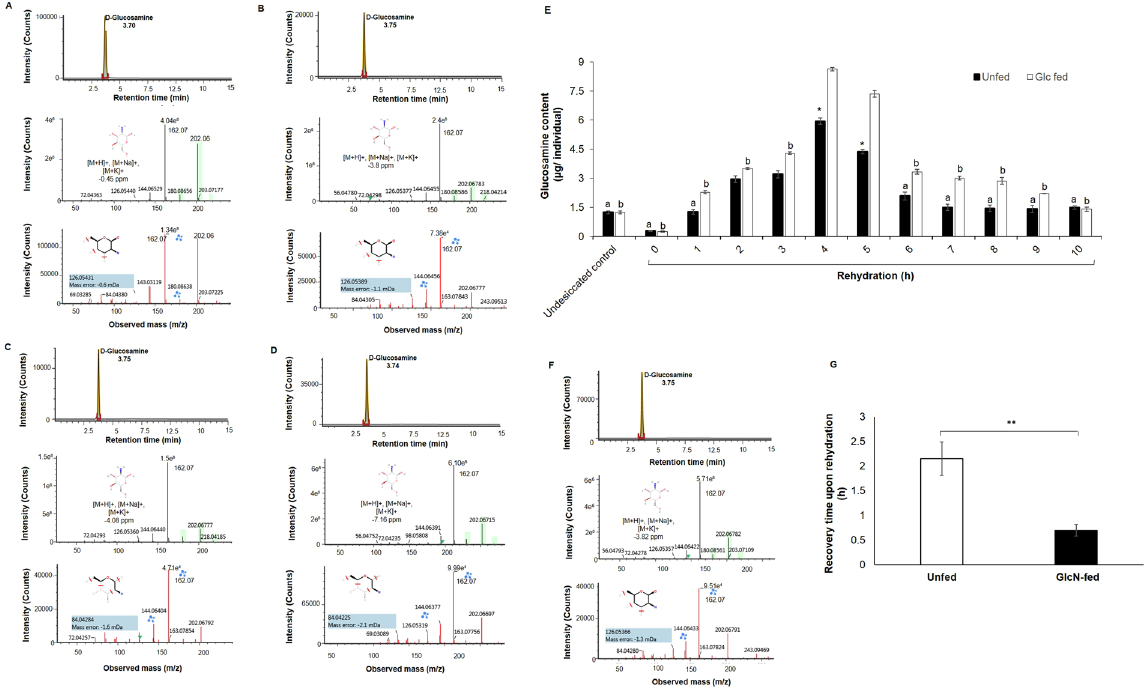
Figure 3. Discovery of glucosamine and the biosynthetic pathway followed during recovery post desiccation. ( A–D ) Representative UPLC-QToF-MS chromatograms indicating the detection of glucosamine. Glucosamine was identified as [M + H] + , [M + Na] + , [M + K] + with mass accuracy 0.45 ppm along with the confirmatory ions (162.07532 Da, 126.05370 Da and 84.04294 Da). ( A ) Standard glucosamine solution. ( B ) Undesiccated control. ( C ) 50 min desiccation. ( D ) 6 h rehydration. ( E ) Comparative glucosamine content in the fed and unfed larvae during rehydration. Of note, glucosamine levels were significantly higher in the fed group as compared to unfed between 4 and 5 h rehydration ( * p < 0.05). Data represented are mean ± SD of three replicates (a = p < 0.05 vs 4 h rehydration in GlcN-unfed group; b = p < 0.05 vs 4 h rehydration in GlcN-fed group). ( F )